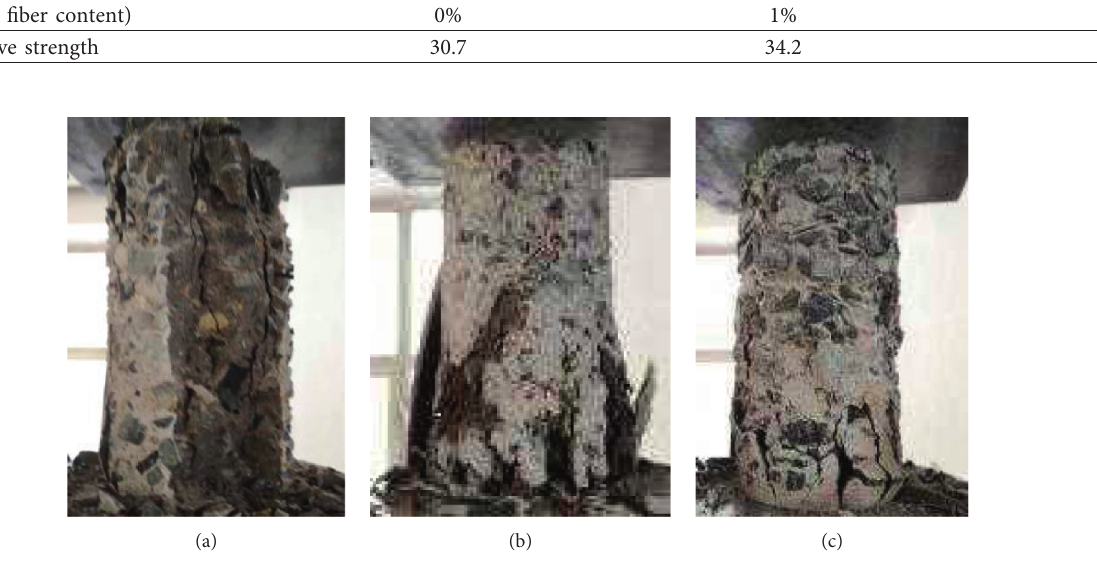
Figure 15: Axial compression test. (a) 0%. (b) 1%. (c)